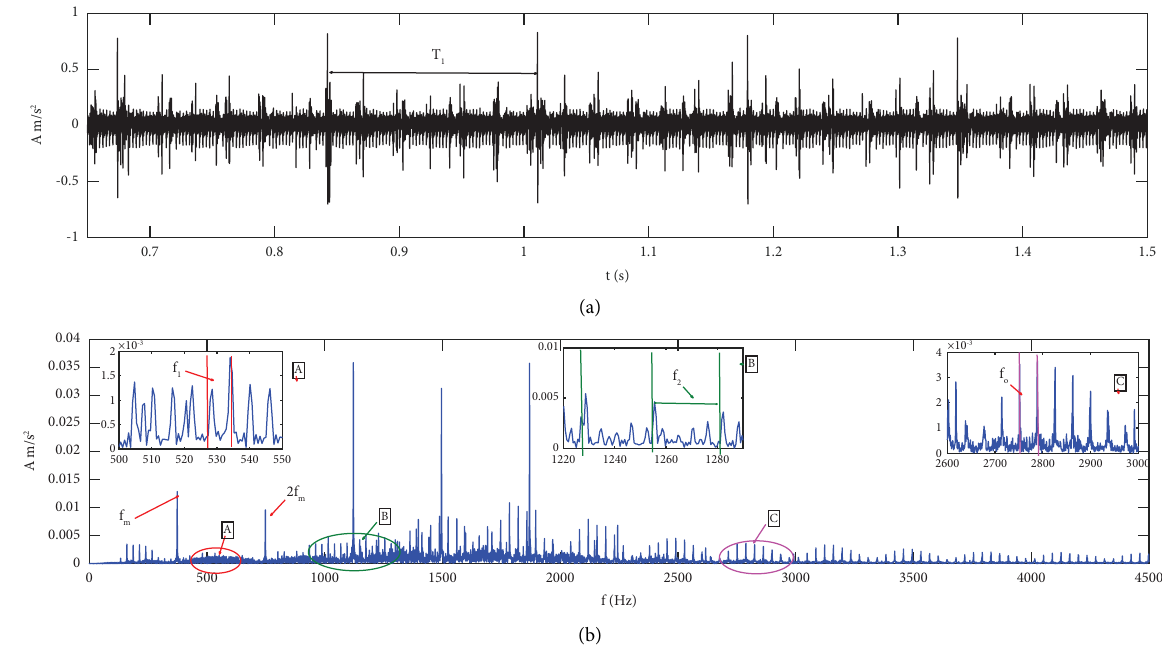
Figure 19: Te responses of the bearing node of the driven shaft with couple fault: (a) the time domain; (b) the frequency